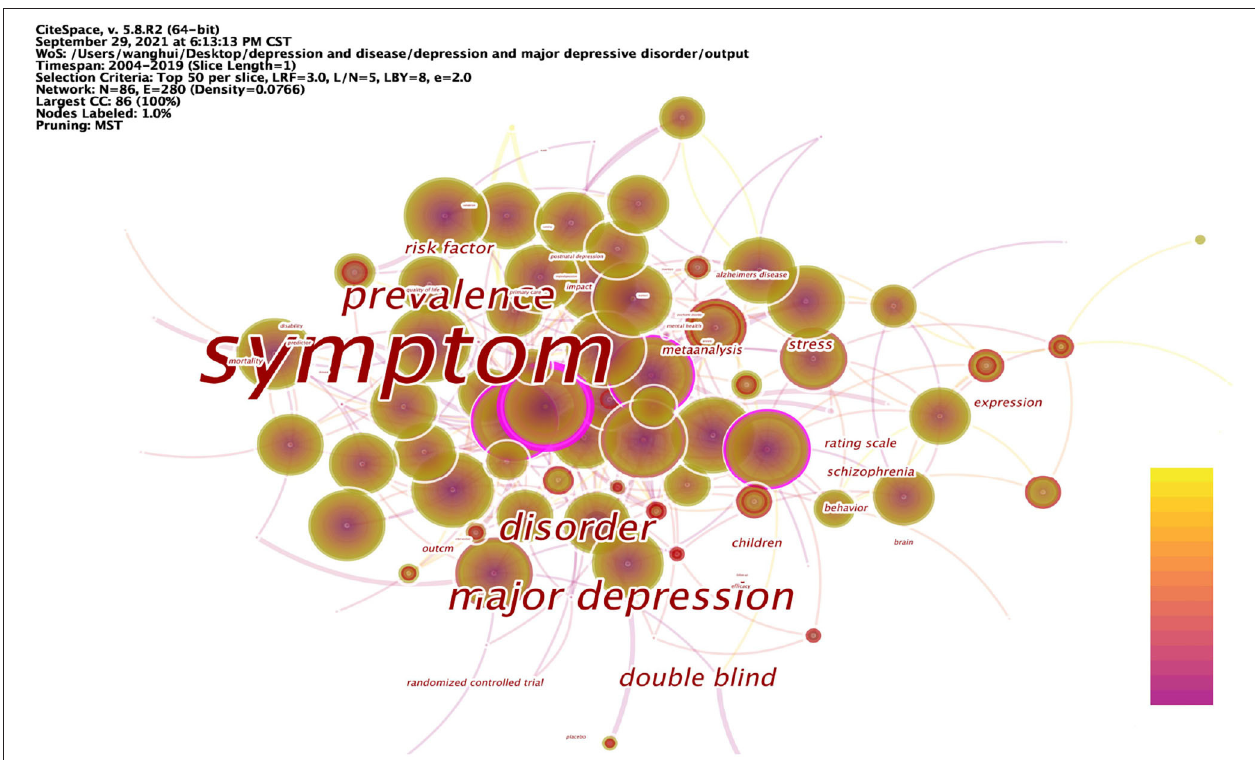
FIGURE 7 | Keyword co-occurrence network in depression,